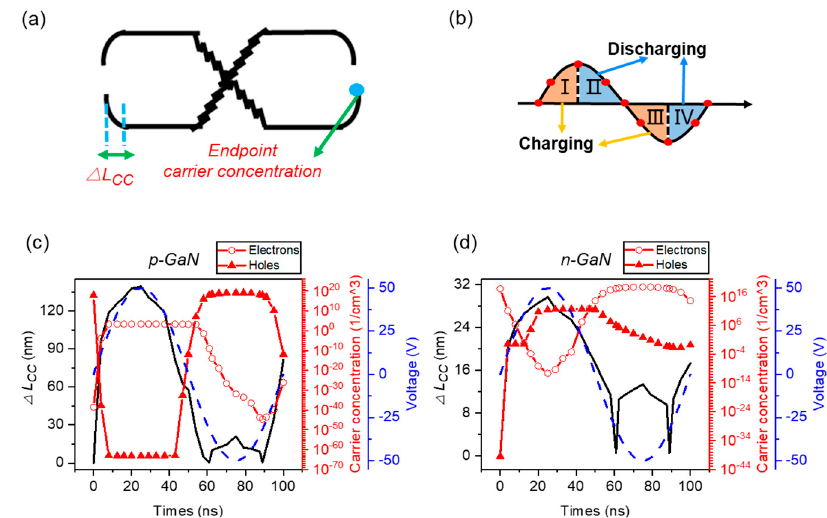
Figure 5. Change of the carrier concentration in p-GaN/n-GaN terminals. ( a ) Definition of Δ L cc . ( b ) Schematic charging and discharging process of the equivalent capacitance. ( c ) Carrier concentration in the p-GaN terminal. ( d ) Carrier concentration in the n-GaN terminal.